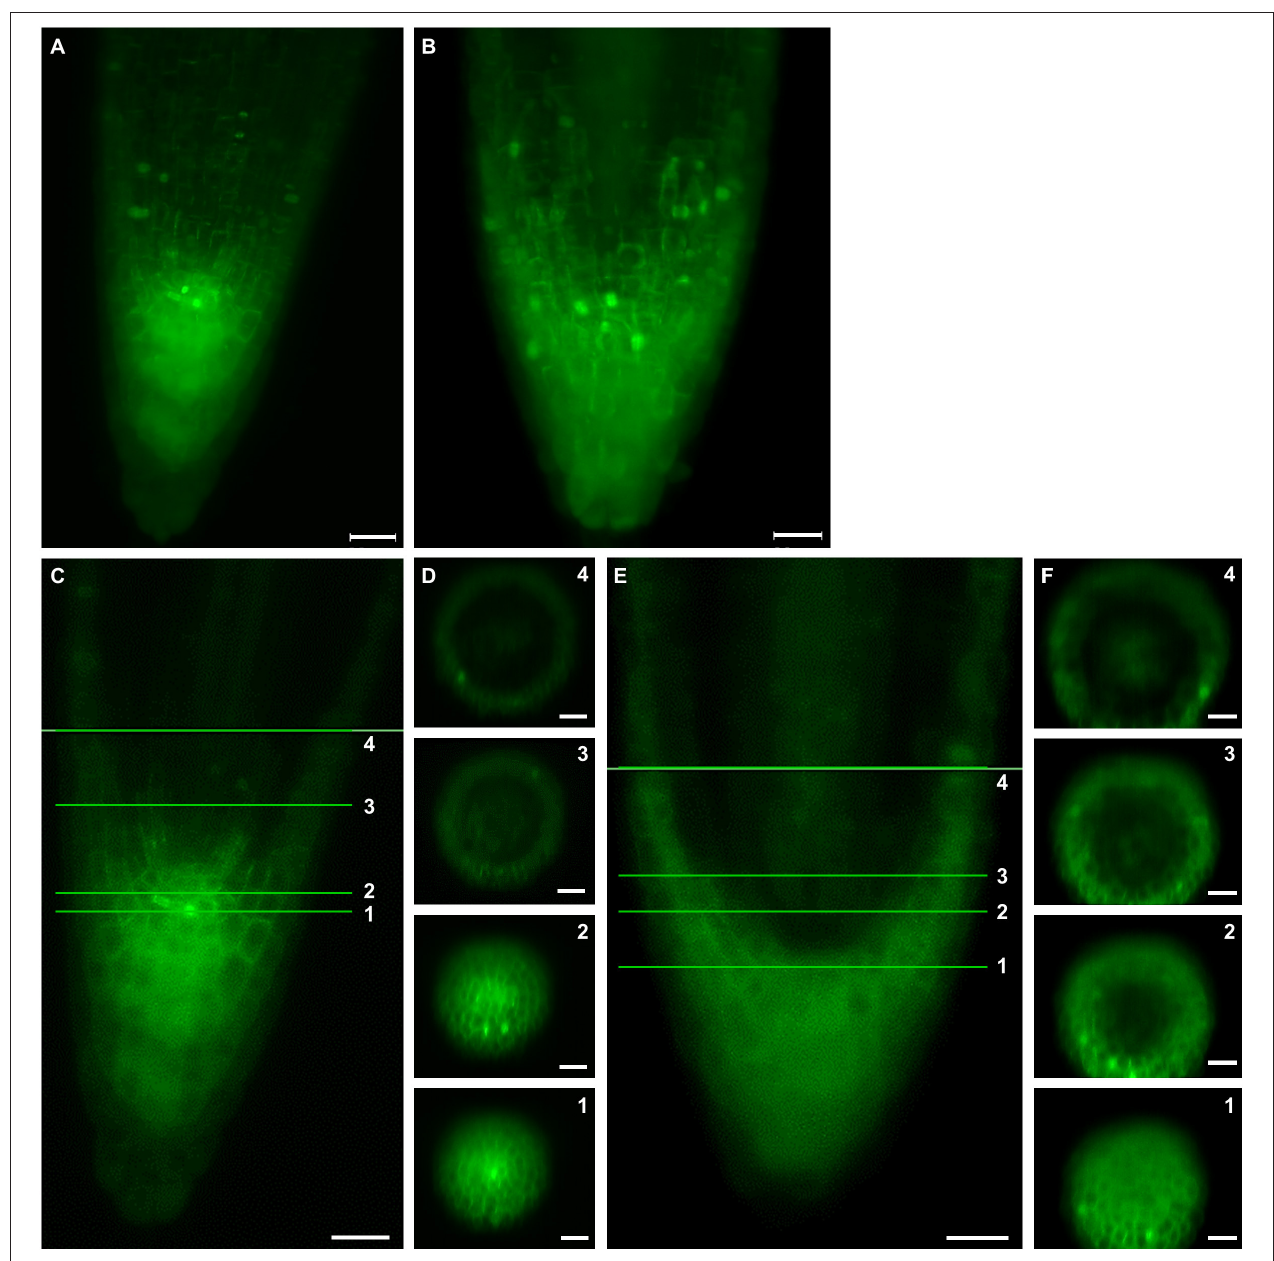
FIGURE 4 | Spatial distribution of cell divisions in meristem and root cap of primary root in Col-0 (A,C,D) and ktn1-2 mutant (B,E,F) . Analyzed plants stably expressed a GFP-TUA6 microtubule marker. (A,B) Volume rendering of a whole root tip showing total number of cell divisons at certain time point in primary root tip of Col-0 (A) and ktn1-2 mutant (B) . (C,E) Median sections of primary root tip of Col-0 (C) and ktn1-2 mutant (E) . (D,F) Orthogonal projections in calyptrogen (1), quiescent center (2), and two other zones (3, 4) in primary root meristem. Bars: (A,B) 20 µ m; (C,E) 50 µ m; (D,F) 100 µ